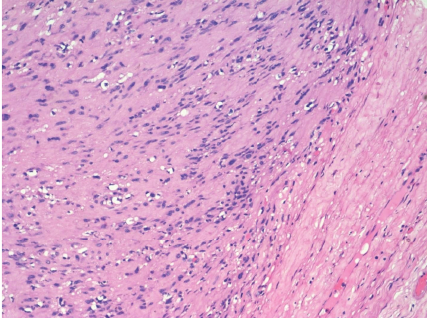
Figure 4: Photomicrograph showing characteristic verocay body with nuclear palisading around fibrillar cellular processes (H&E